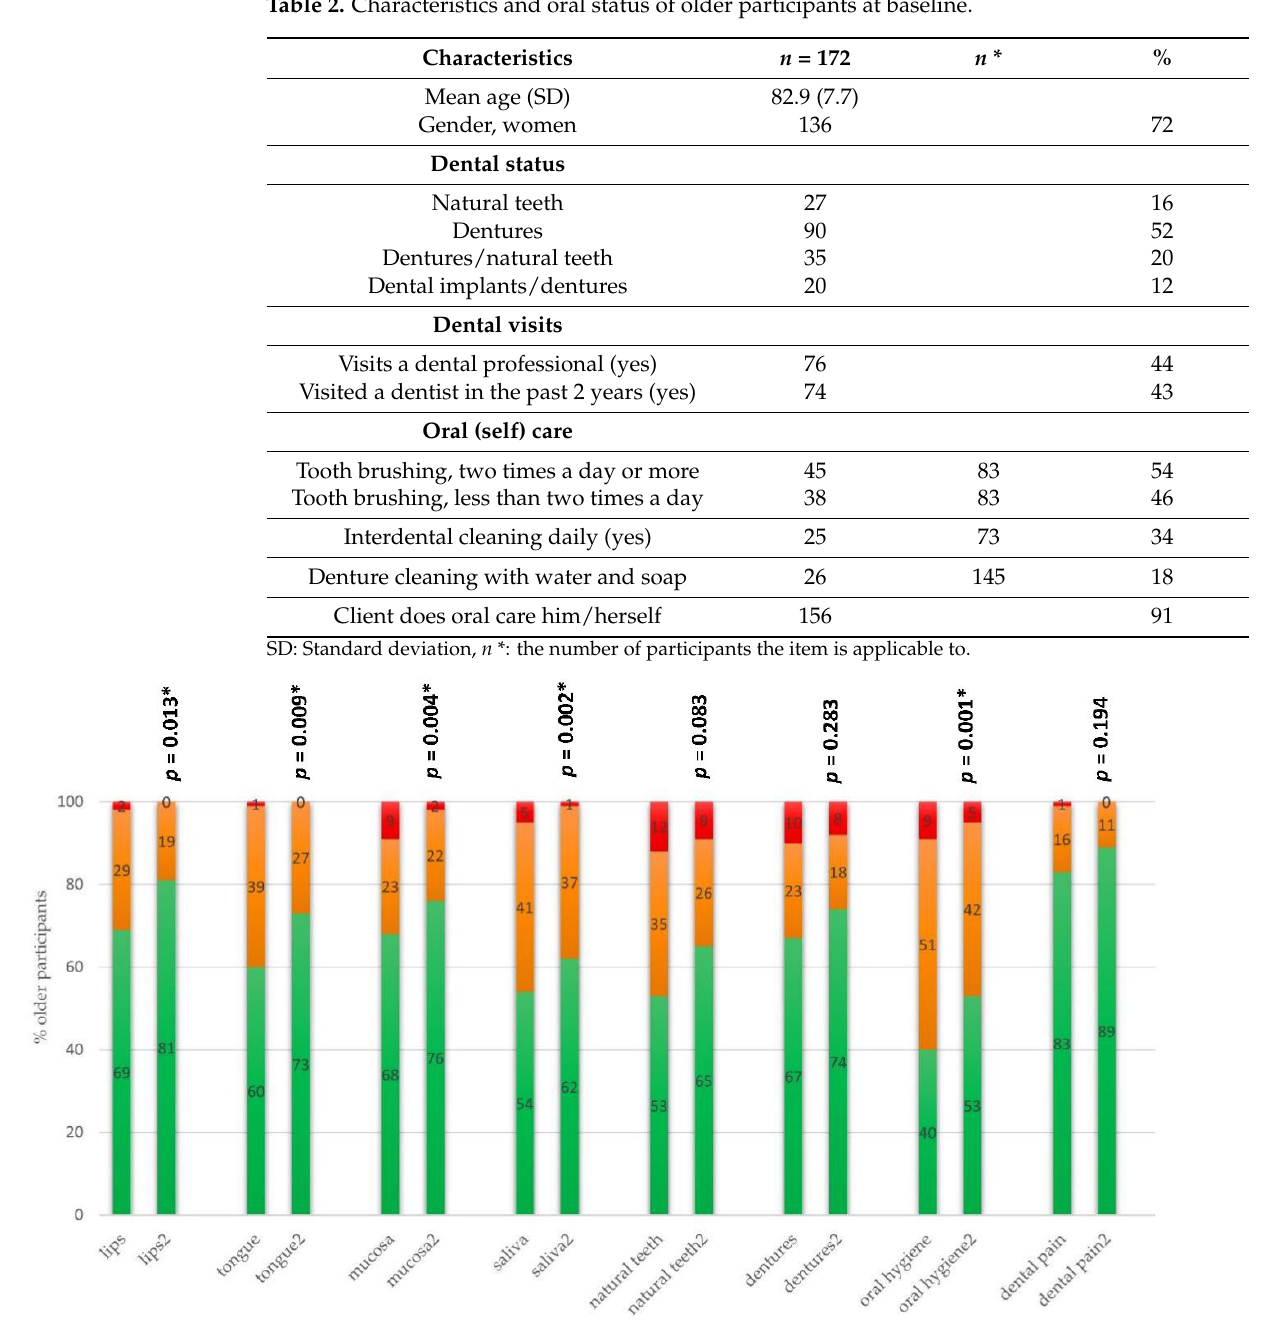
Table 2. Characteristics and oral status of older participants at baseline.